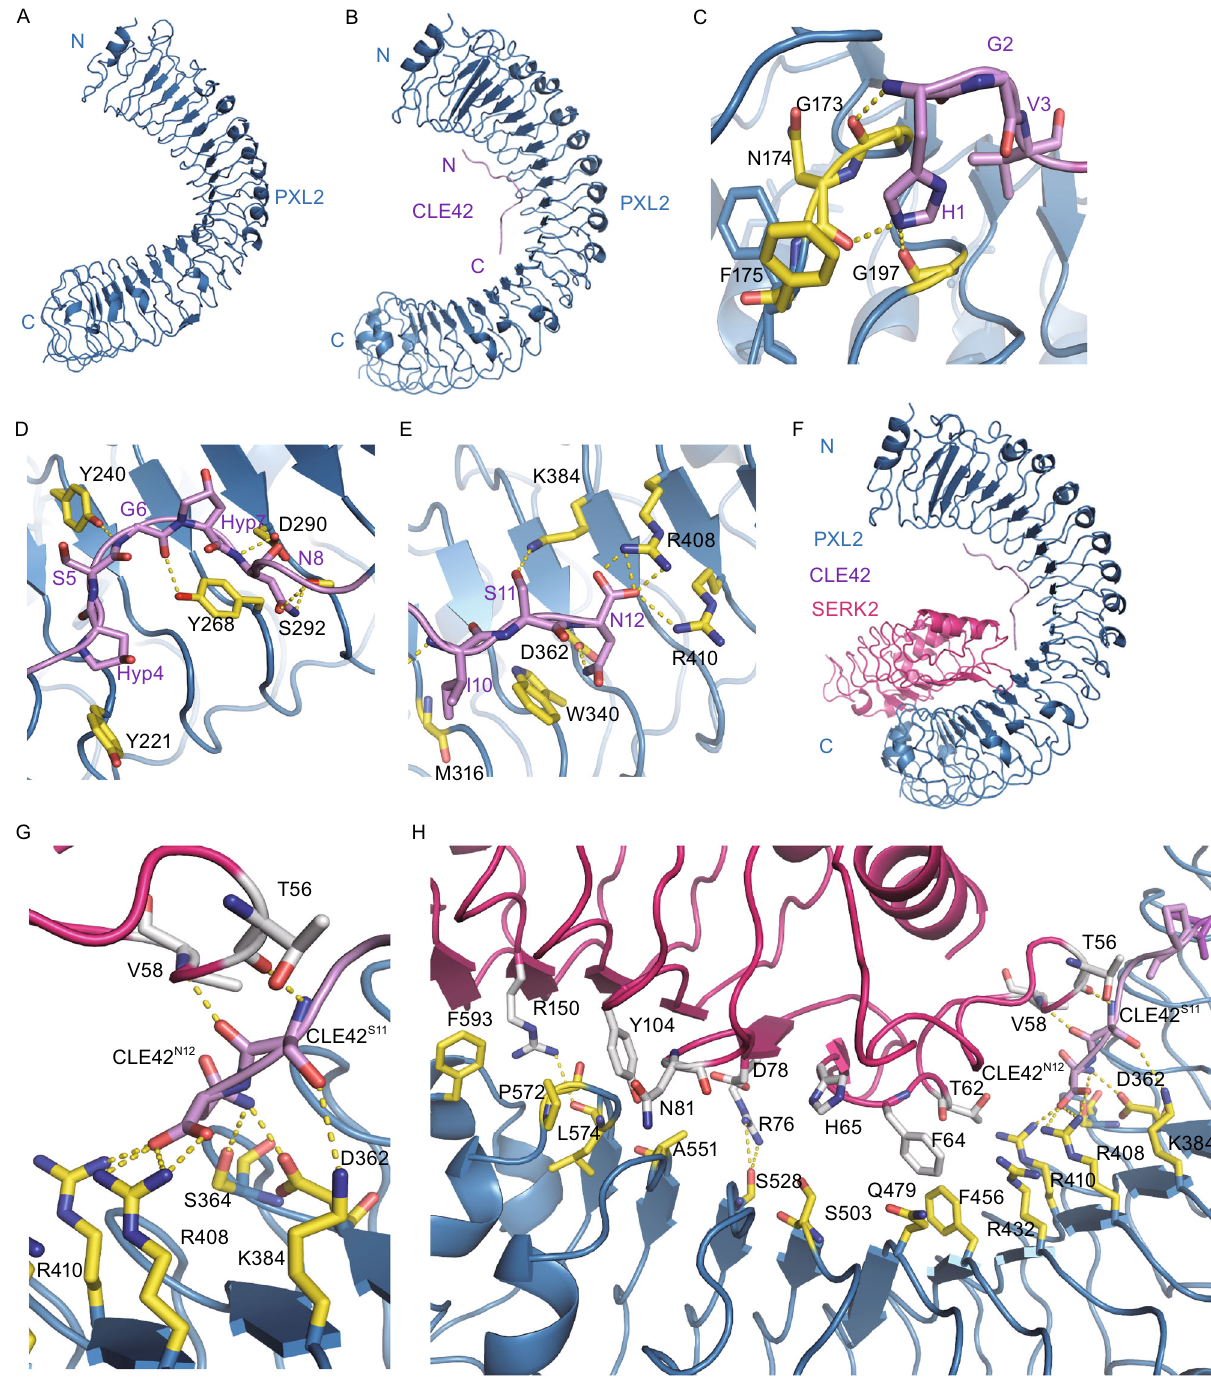
Figure 2. Modeled structure of CLE42-PXL2 LRR and PXL2 LRR -CLE42-SERK2 LRR . (A) Crystal structure of PXL2 LRR alone shown in cartoon.(B)ModeledstructureofPXL2 LRR -CLE42complexusingasthePXY LRR -CLE41template.CLE42adoptsan “ Ω ” -likekinkandbindstothe concave surface of PXL2 LRR . (C) Detailed interaction of the N-terminal side of CLE42 withPXL2 LRR . The sidechains of someamino acids from CLE42andPXL2 LRR areshowninvioletandyelloworange,respectively.Yellowdashedlinesindicatehydrogenbondsorsaltbridges.(D)Detailed interactionofthecentralregionofCLE42withPXL2 LRR .(E)DetailedinteractionoftheC-terminalsideofCLE42withPXL2 LRR .(F)Modelstructure of PXL2 LRR -CLE42-SERK2 LRR complex. (G) Detailed interaction between the C-terminal residues Ser11 and Asn12 of CLE42 and PXL2, SERK2.ThesidechainsofsomeaminoacidsfromCLE42,PXL2 LRR ,andSERK2 LRR areshowninviolet,yelloworange,andpink,respectively. Yellow dashed lines indicate hydrogen bonds or salt bridges. (H) Detailed interaction between PXL2 LRR -CLE42 and SERK2 LRR